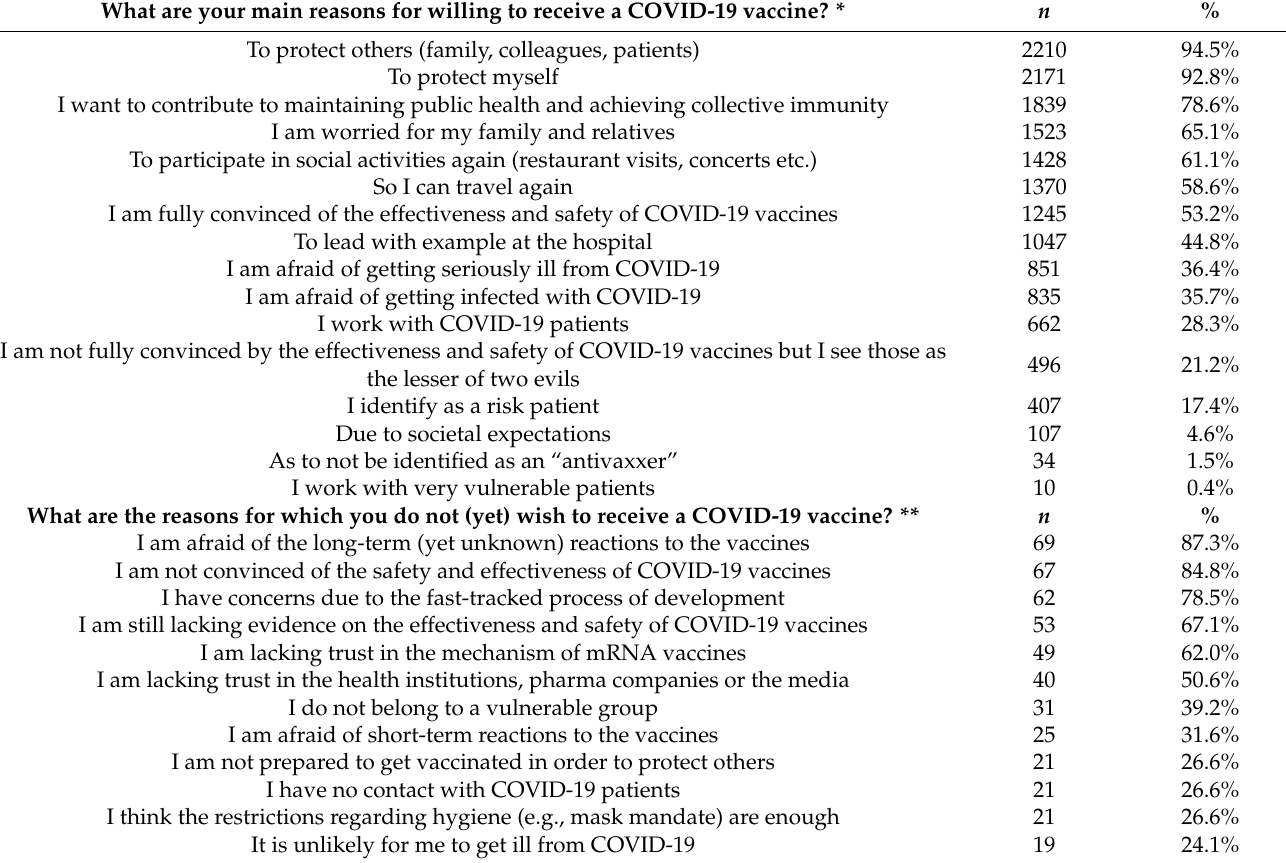
Table 2. Frequencies of the reasons for the respective decision on COVID-19